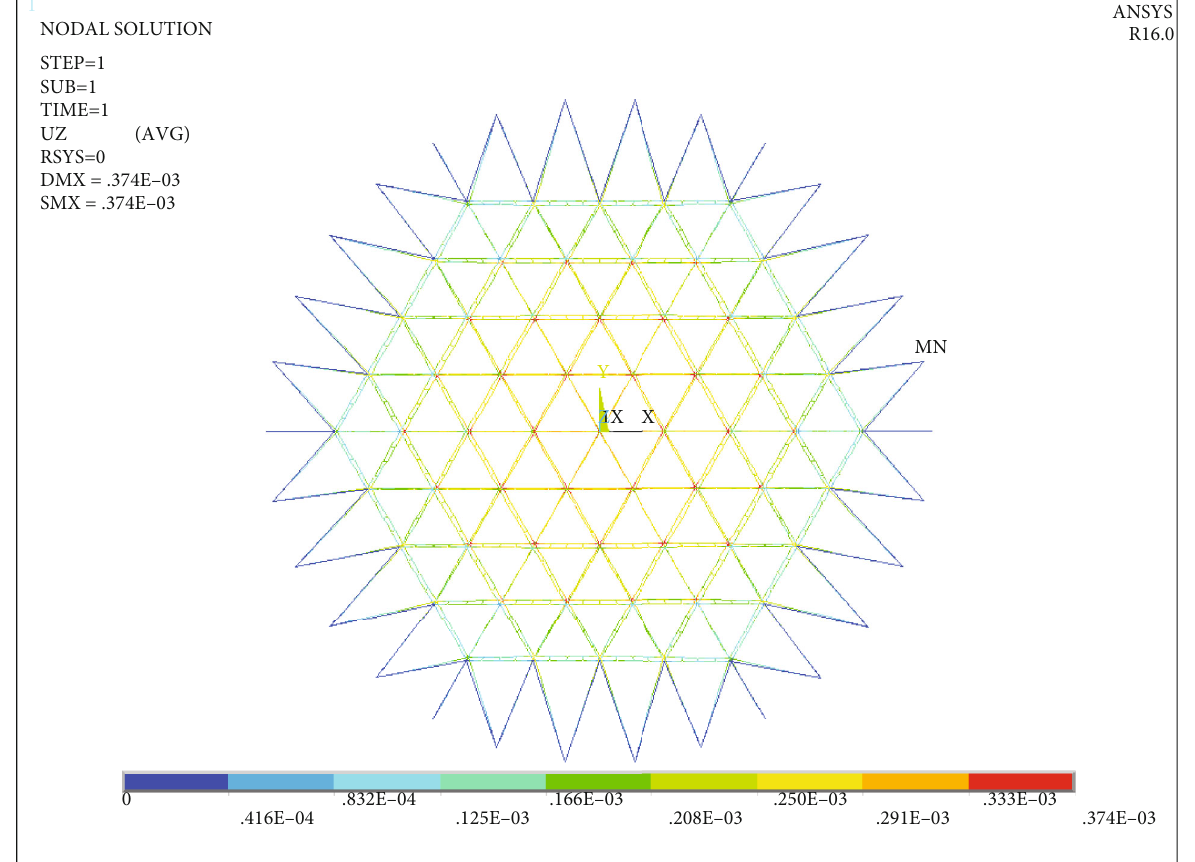
Figure 1: Nodal displacement calculated by ANSYS: subdivided fi nite element model.